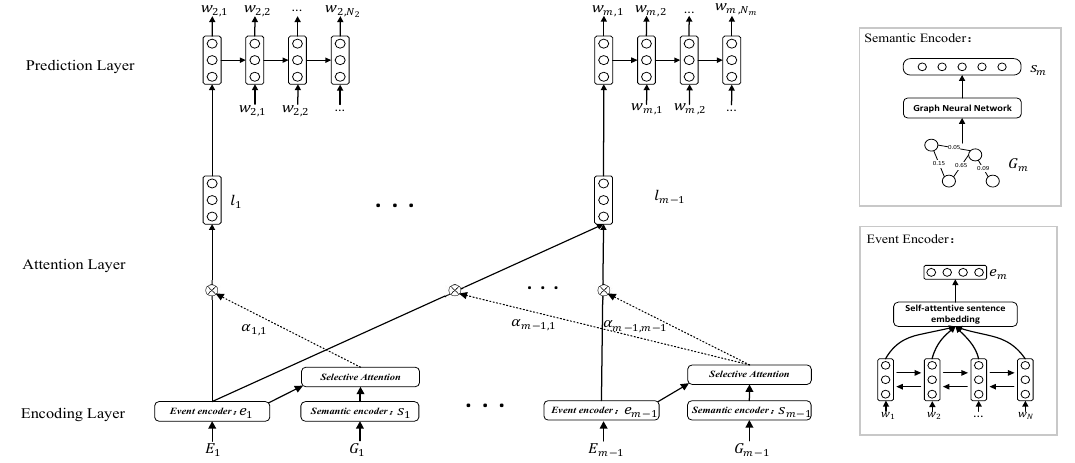
Figure 2. Illustration of our proposed HS-GRU model for event prediction. The encoding layer obtains the time-based event information and prior knowledge of current event link. The attention layer fuses time-based event information and prior knowledge by semantic selective attention mechanism. The prediction layer is used to generate the next event text